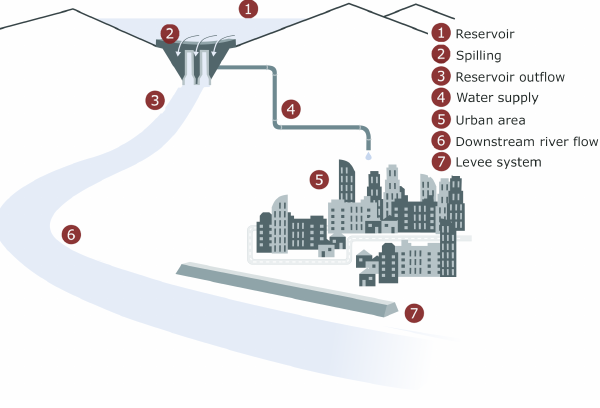
Fig. 2 . Schematic representation of a generic case study conceptualized in the proposed system-dynamics